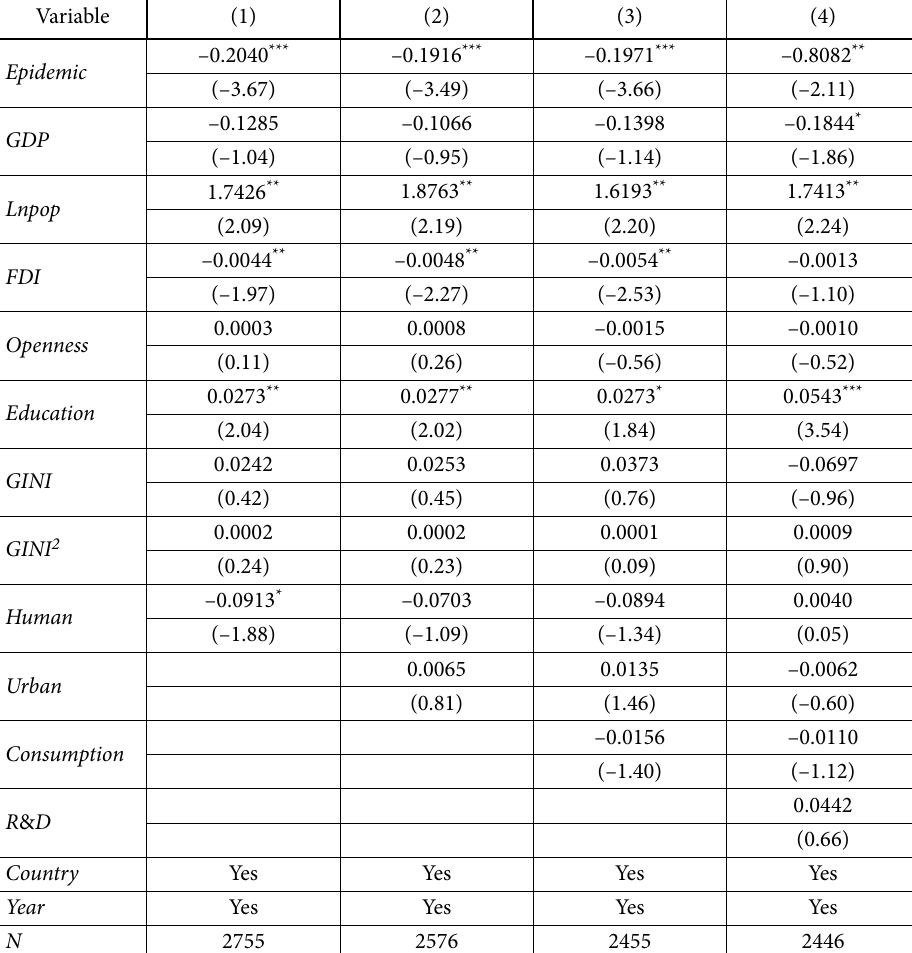
Table 7. Robustness tests: adding more control